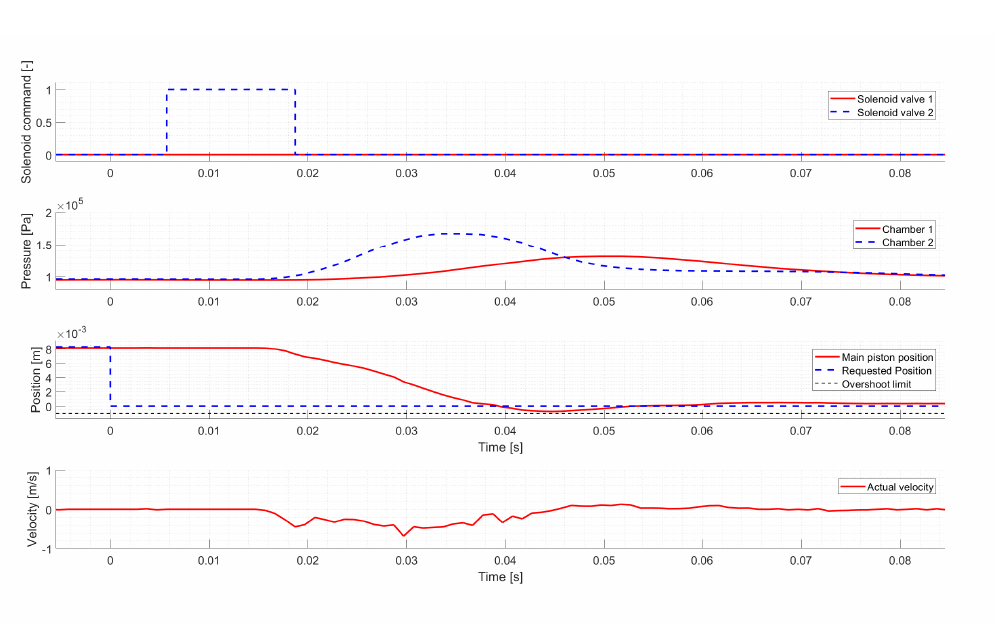
Figure 11. High to Neutral gear change (measurement).